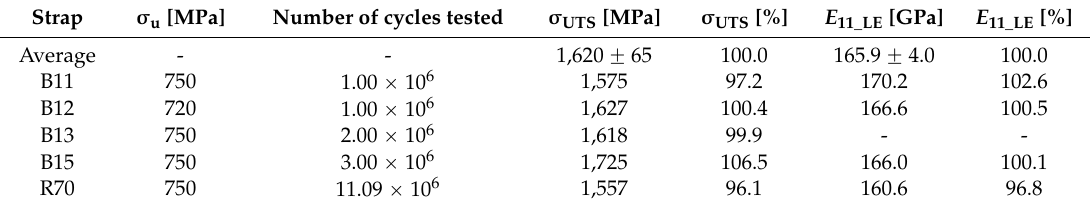
Table 2. Straps tested for their residual strength and stiffness properties after 1, 2, 3 and 11 million load cycles at an upper stress level ( σ u ) of 720–750 MPa. The fibre parallel elastic modulus E 11 was calculated from linear encoder measurements ( E 11_LE ). Straps are labelled with B or R, depending the author who manufactured them, followed by the number of the strap.